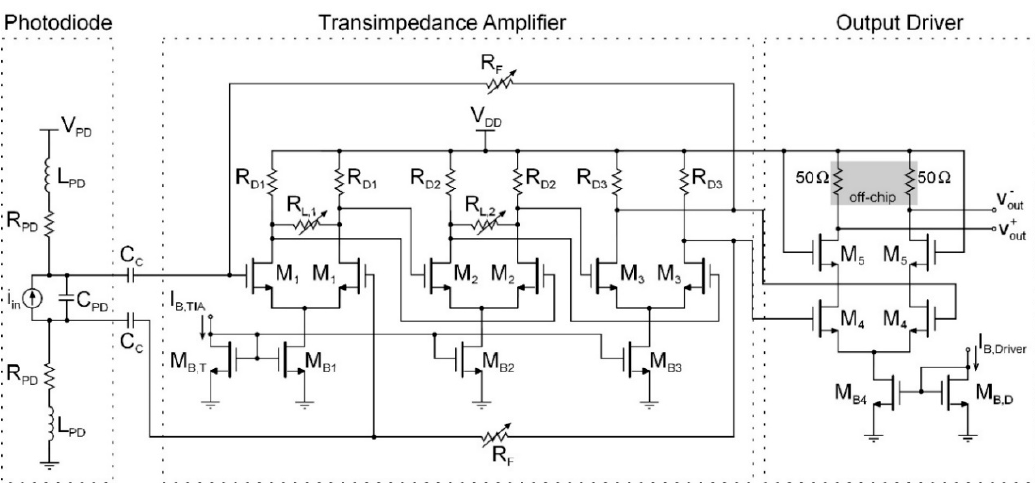
Figure 3. Transistor-level topology of the proposed low-noise transimpedance amplifier (TIA) for the remote antenna unit (RAU) downlink. An output driver is included for measurement purposes.